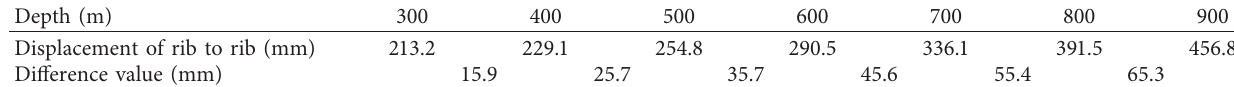
Table 4: Comparison of the final displacement of mining roadway ribs.